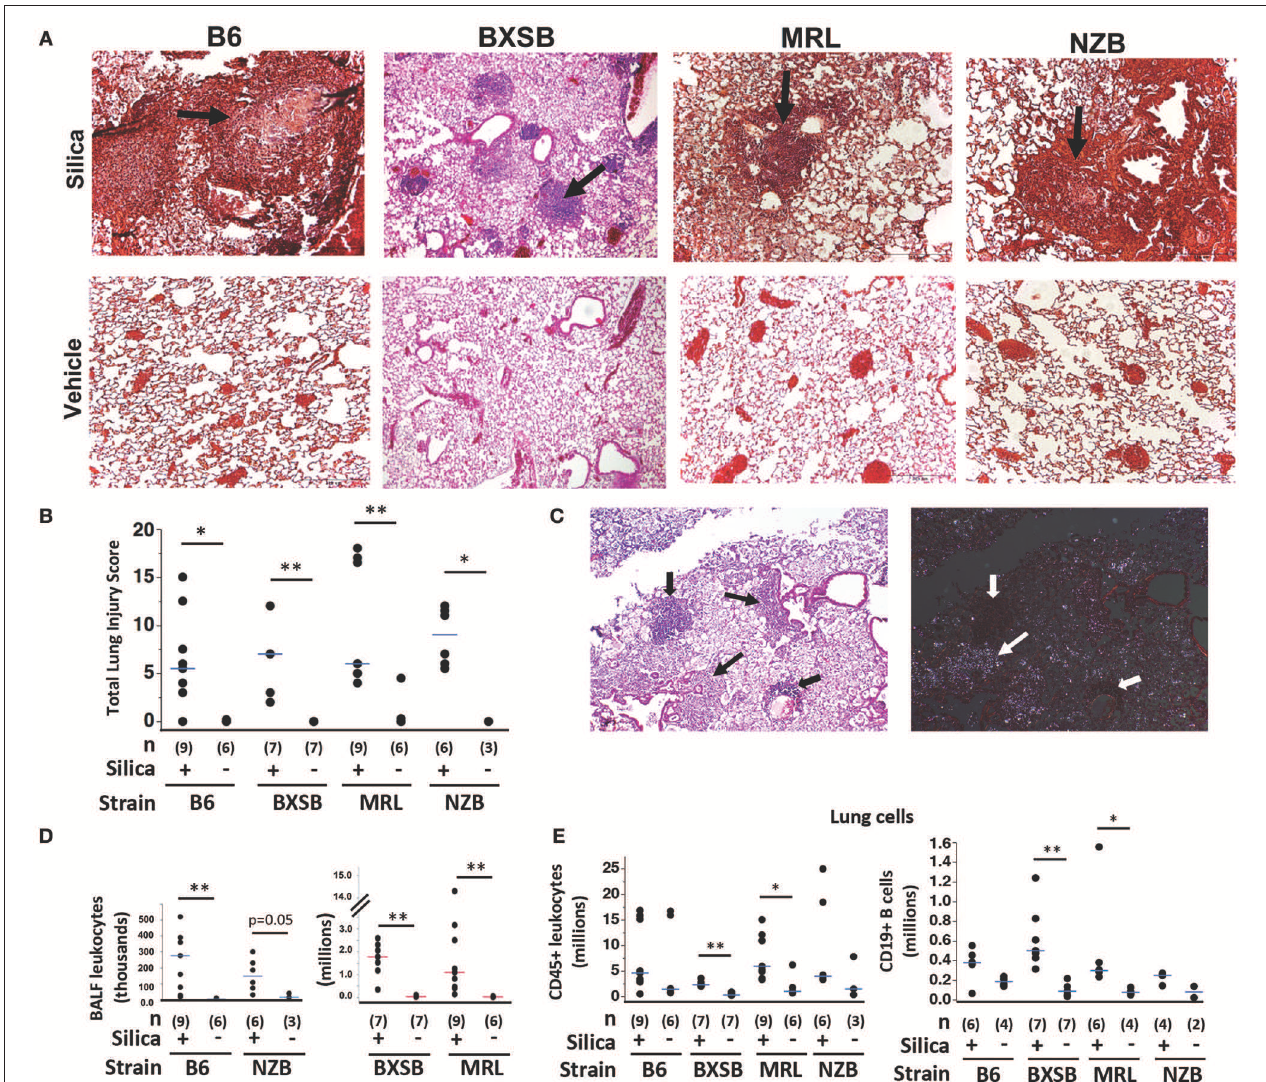
FIGURE 1 | Lung injury and inflammation in diverse wildtype mouse strains after exposure to crystalline silica. (A) Representative sections of lung from mice of indicated strain 2 months (MRL) or 3 months (B6, BXSB, NZB) after instillation of silica or vehicle; H&E, original magnification × 40. Arrows indicate granulomas. (B) Lung injury composite scores for mice of each strain after exposure to silica or vehicle. (C) Localization of silica particles in a representative H&E stained section of lung tissue from an MRL mouse 1 month after silica instillation, viewed by conventional (left) or polarizing (right) light microscopy; thin arrows indicate granulomas, thick arrows indicate lymphoid collections. (D) Leukocytes in BAL fluid, counted using Diffquick. (E) CD45 + leukocytes (left) and CD45 + CD19 + B cells (right) in whole lung cell isolates of mice after exposure were quantitated by flow cytometry, gated on live cells. For data in scatterplots, lungs were harvested 1, 2, and 3 months post-exposure for each group, except for BXSB for which lungs were harvested at 2 or 3 months post-exposure. Each symbol represents an individual mouse, with tissue harvested at 1, 2, or 3 months after exposure; the median for each group is indicated by the bar; * p < 0.05 and ** p < 0.01 for silica- vs. vehicle-exposed mice of same strain, Wilcoxon rank sum